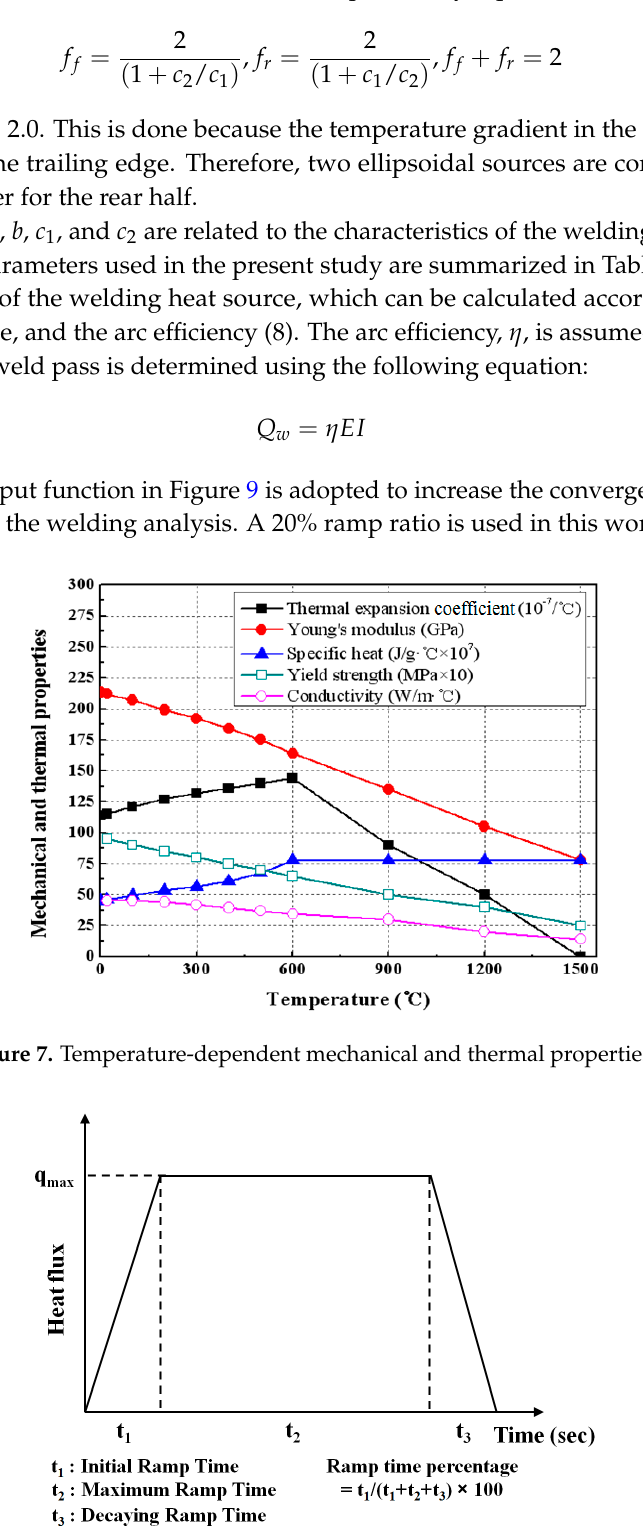
Figure 8. Shape of the ramp heat input function.